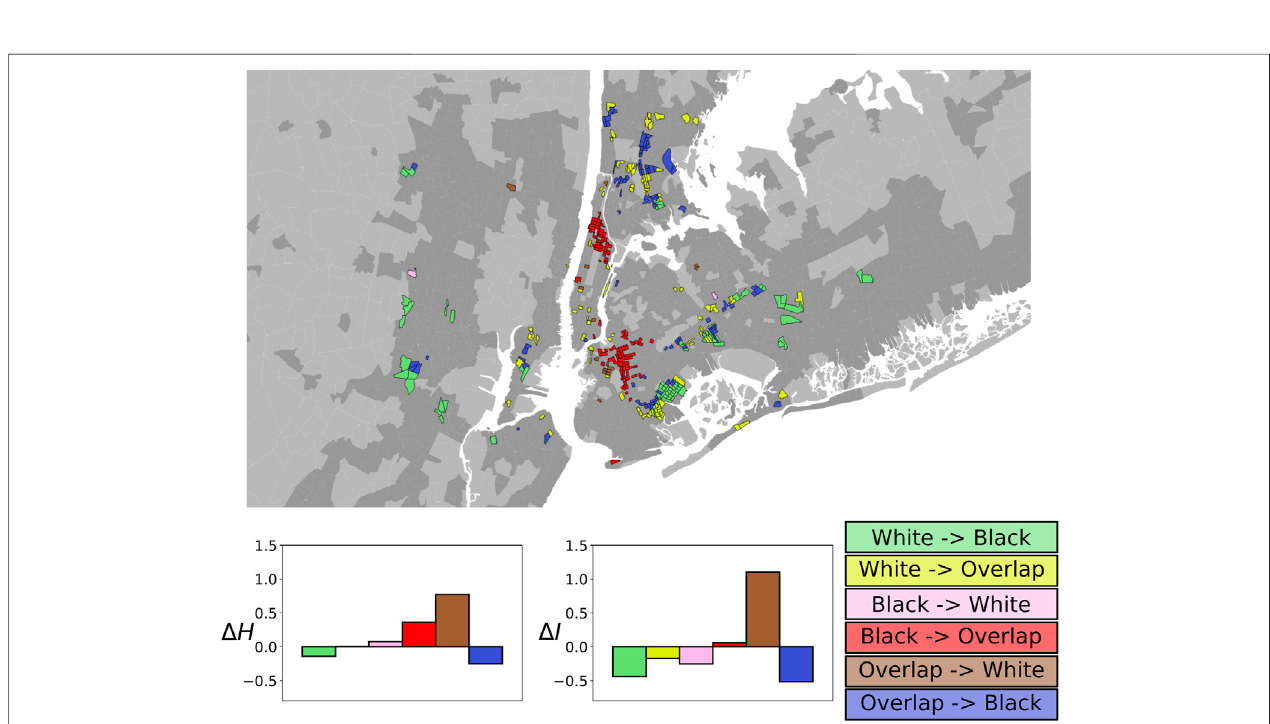
FIGURE5| TractsthatmigratedfromonezonetoanotherortotheOverlapzonefrom1990to2010:whiteandblackcitizens.Tractsthatchangedzonefrom1990 to 2010 are shown on the map, while the colors indicate the change from white to black (green), from white to overlap (yellow), from black to white (pink), from black to overlap(red),fromoverlaptowhite(brown),andfromoverlaptoblack(blue).Furthermore,foreachmigrationalternative,thevaluesof Δ H and Δ I areshownatthebottom panels.